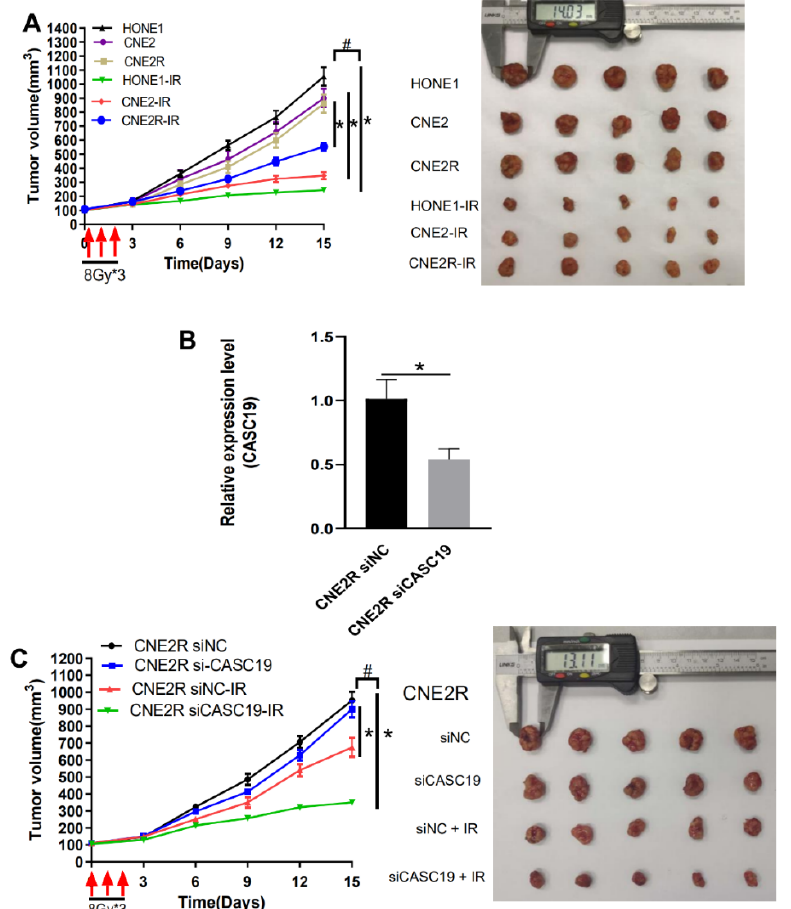
Figure 4. CASC19 knockdown-enhanced radiosensitivity of NPC xenograft tumors. ( A ) Tumor growth curves and representative images of HONE1, CNE2, and CNE2R xenografts in nude mice. The xenografts were irradiated with 8 Gy × 3 under a volume of about 100 mm 3 . * p < 0.05 between indicated groups of same cell line; # p < 0.05 between indicated different cell lines before and after irradiation. ( B ) RT-qPCR assay of the CASC19 expression in the CNE2R xenograft tumors that were intratumorally injected with cholesterol-modified CASC19 siRNA every 3 days from the time-point of the tumor having a volume of about 50 mm 3 until the mice were sacrificed. ( C ) Tumor growth curves and representative image of CNE2R xenograft tumors under different treatments of siNC, siCASC19, siNC + ionizing radiation (IR), and siCASC19 + IR, respectively. * p < 0.05 between same cells before and after irradiation. # p < 0.05 between CNE2R siNC group and CNE2R siCASC19 group before and after irradiation.